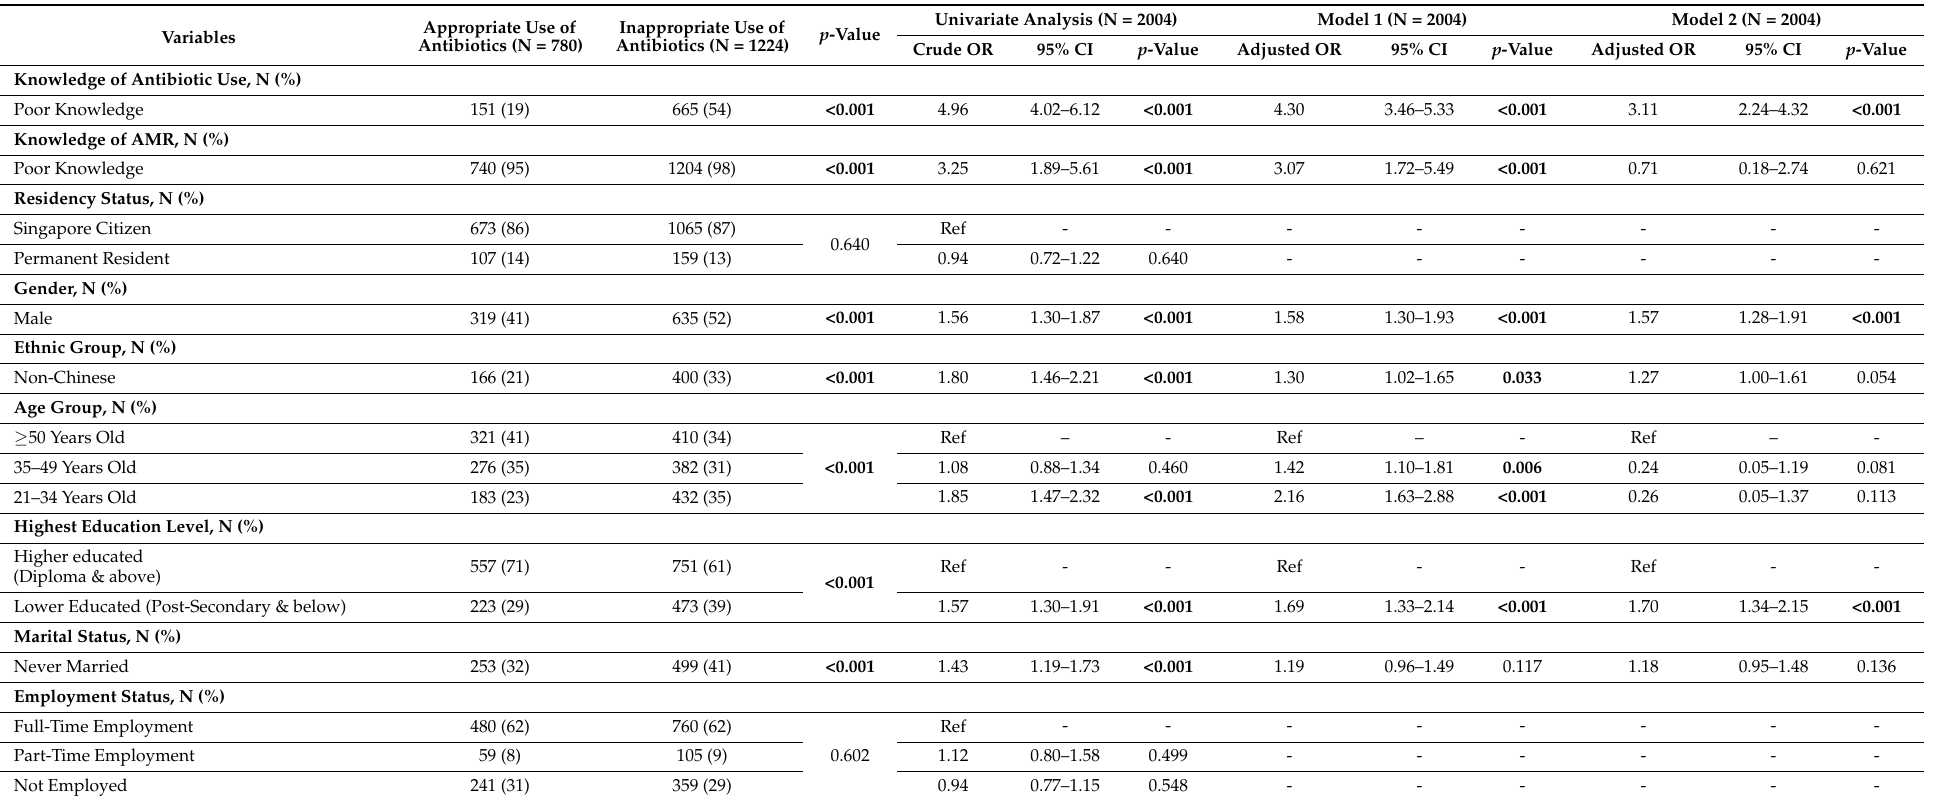
Table 3. Univariate and multivariable logistic regression analyses on factors influencing inappropriate use of antibiotics amongst 2004 Singapore residents